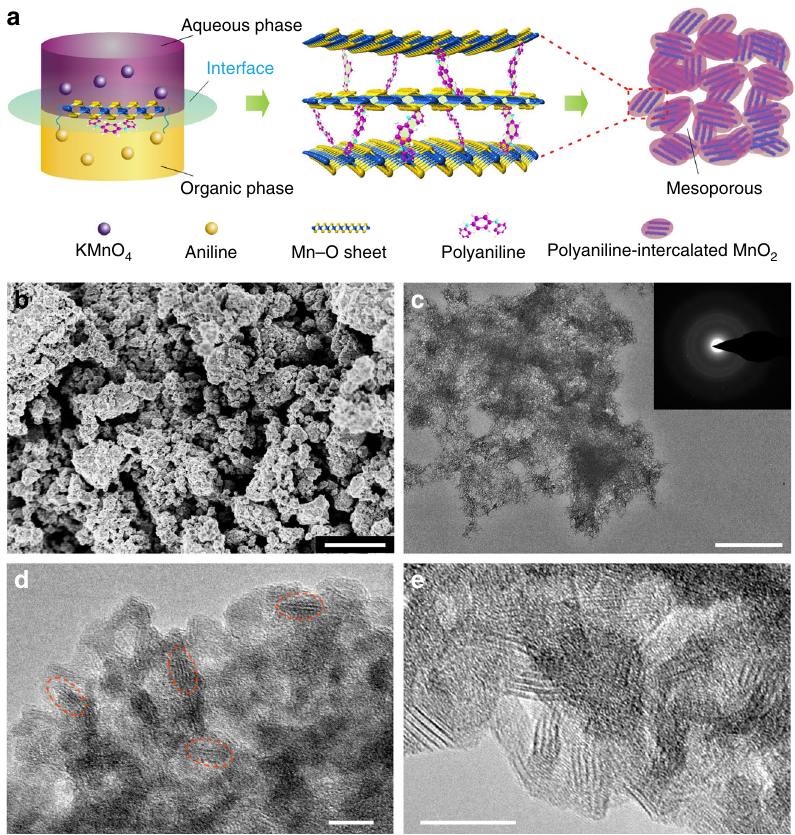
Fig. 1 Preparation and characterization of the polyaniline-intercalated MnO 2 nanolayers. a Schematic illustration of expanded intercalated structure of polyaniline (PANI)-intercalated MnO 2 nanolayers. b Scanning electron microscopy image, c transmission electron microscopy (TEM) image (the inset shows the corresponding selected-area electron diffraction image), and d high-resolution (HR)-TEM image of the PANI-intercalated MnO 2 nanolayers. The red dashed outlines are used to clarify the morphology pro fi le and particle size of the MnO 2 nanolayers. e HR-TEM image of the PANI-intercalated MnO 2 nanolayers with heat treatment at 400 °C to remove the shield of PANI. Scale bars, b 1 μ m; c 500 nm, and d , e 10 nm,